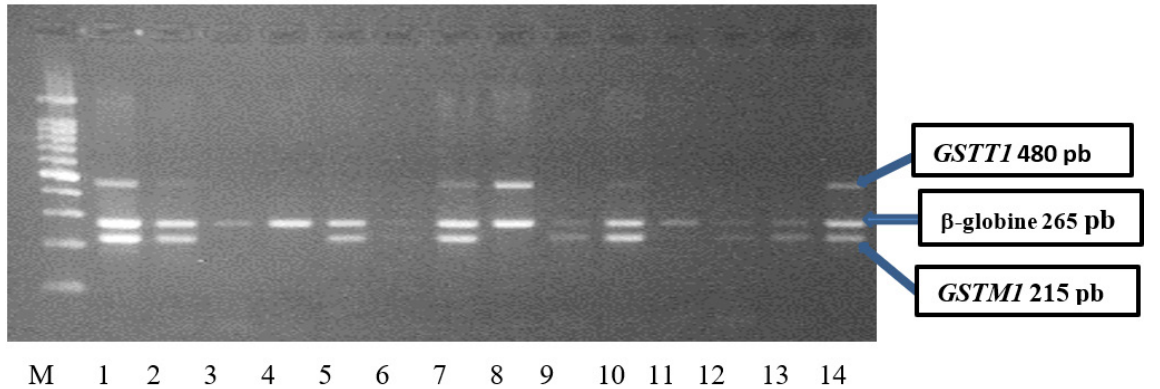
Figure 1: PCR-multiplex electrophoresis gel. M = Molecular weight marker (100 bp); 1; 7 et 14 = Double present genotypes of GSTM1 and GSTT1 ; 2; 5; 10; 12 et 13 = Genotypes of GSTM1 present and GSTT1 null; 3 ; 4; 11 = Double genotypes null of GSTM1 and GSTT1 ; 6; = invalid; 8 GSTM1 null and GSTT1